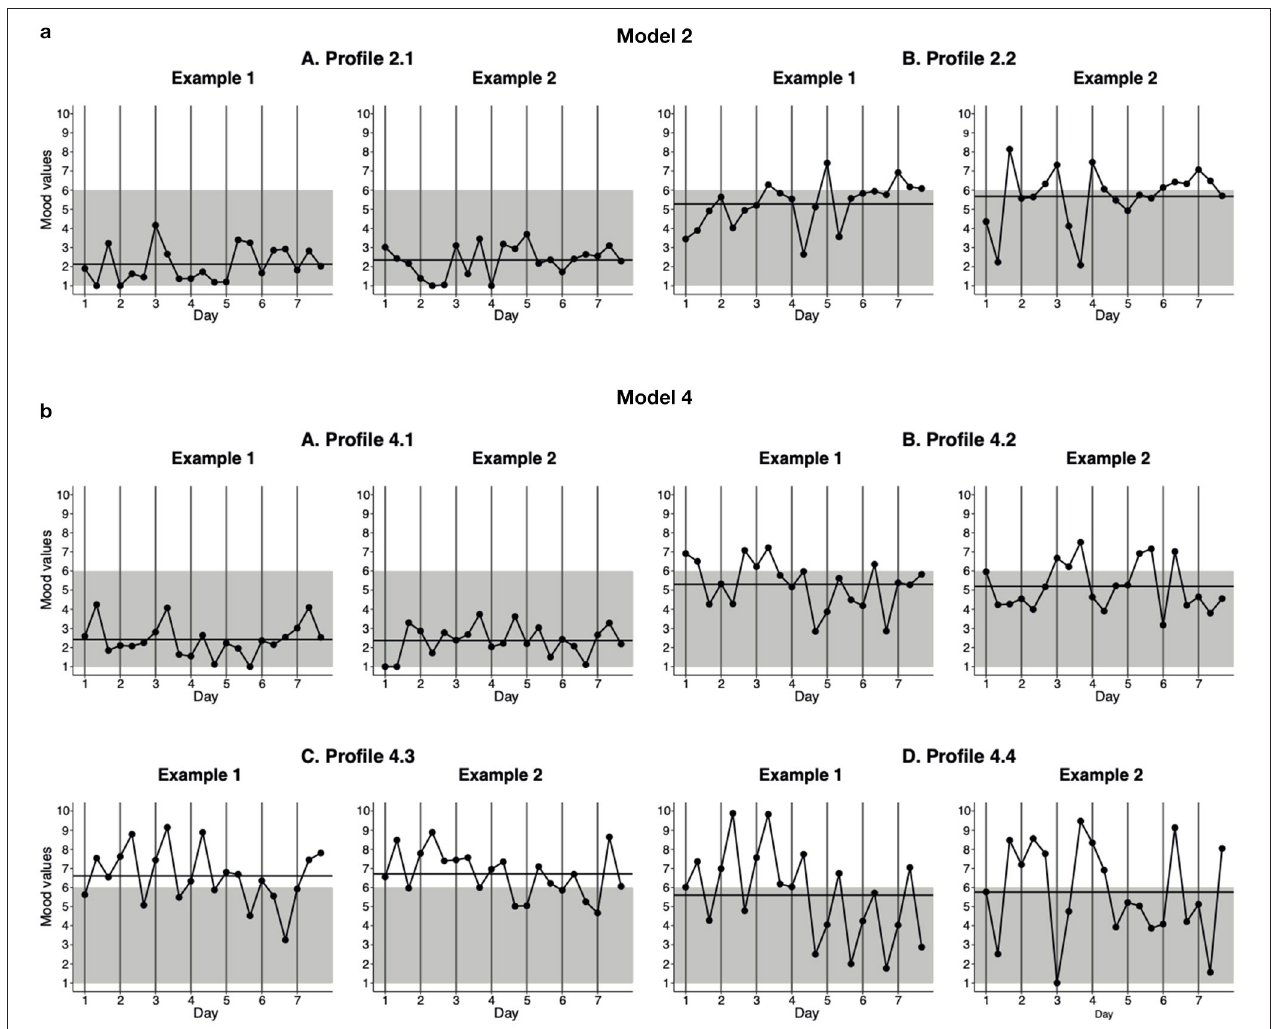
FIGURE 2 | Generated EMA-response patterns of the profiles of the two- and four-profile models. The data for these graphs were generated using the standardized mean scores for the indicators of the profiles using the estimated parameters shown in Table 2 . Three EMA assessments were completed each day, at 10a.m., 8 p.m., and at a random time between 10a.m. and 10 p.m. The horizontal black line represents the AM across the 7-day monitoring period, while the gray background represents negative mood (score < 6) and the white area represents positive mood ( ≥ 6). (a) Model 2. (b) Model 4.